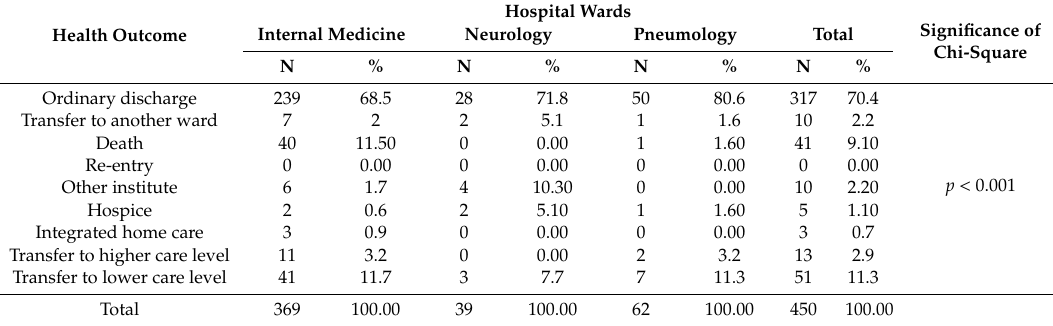
Table 6. Health outcome by hospital